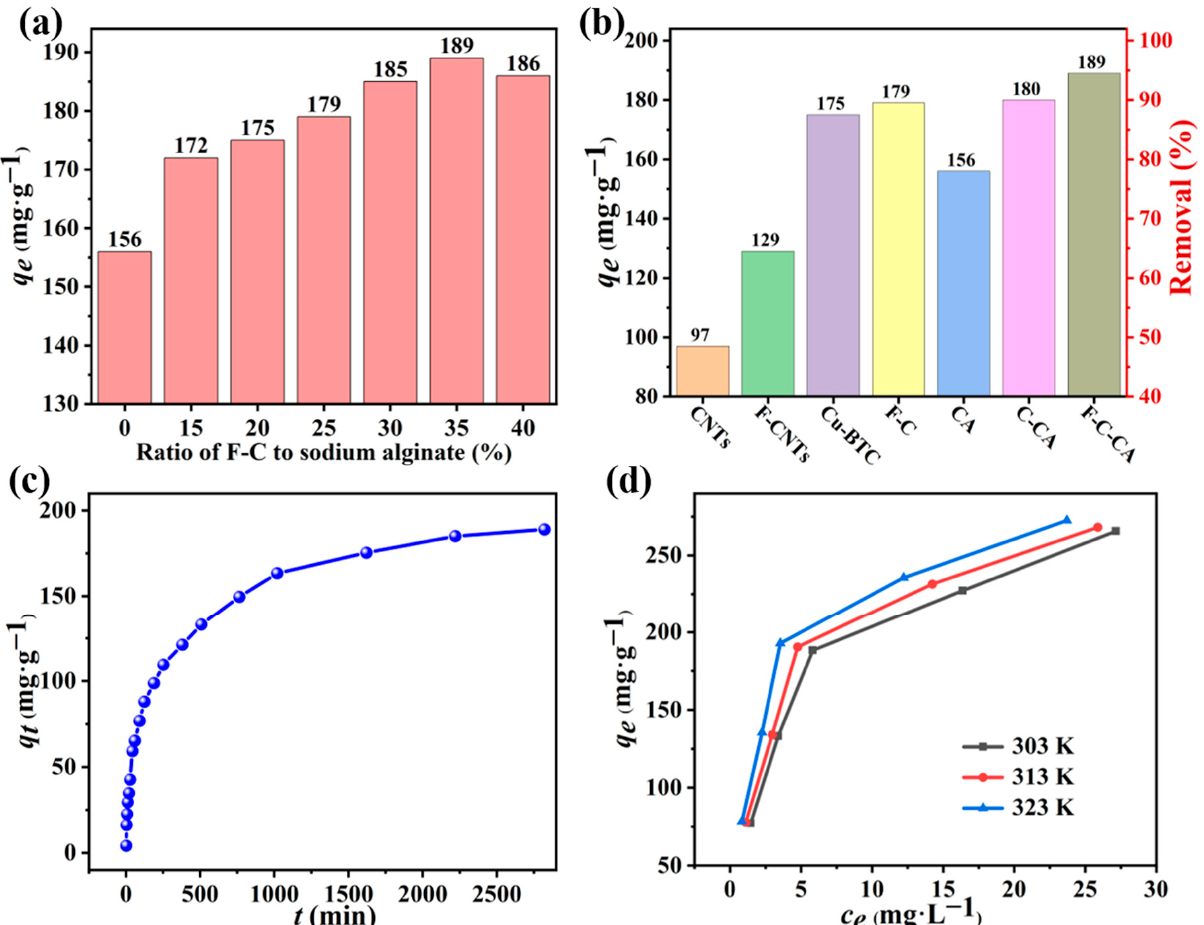
Figure 5. ( a ) The effect of F-C content on adsorption capacity. ( b ) Results of adsorption capacity of different materials. The influence of contact time ( c ) and temperature ( d ) on adsorption effect.